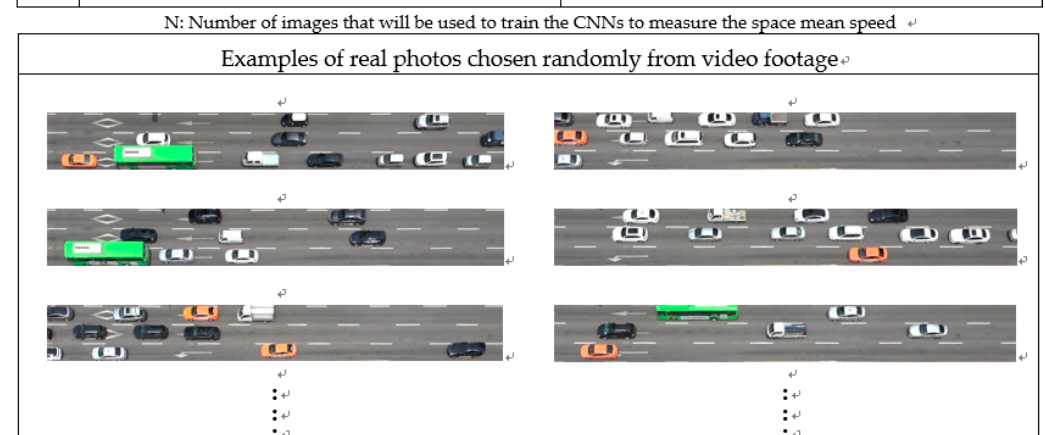
Figure 10. Comparison among animated, synthesized, and real images.